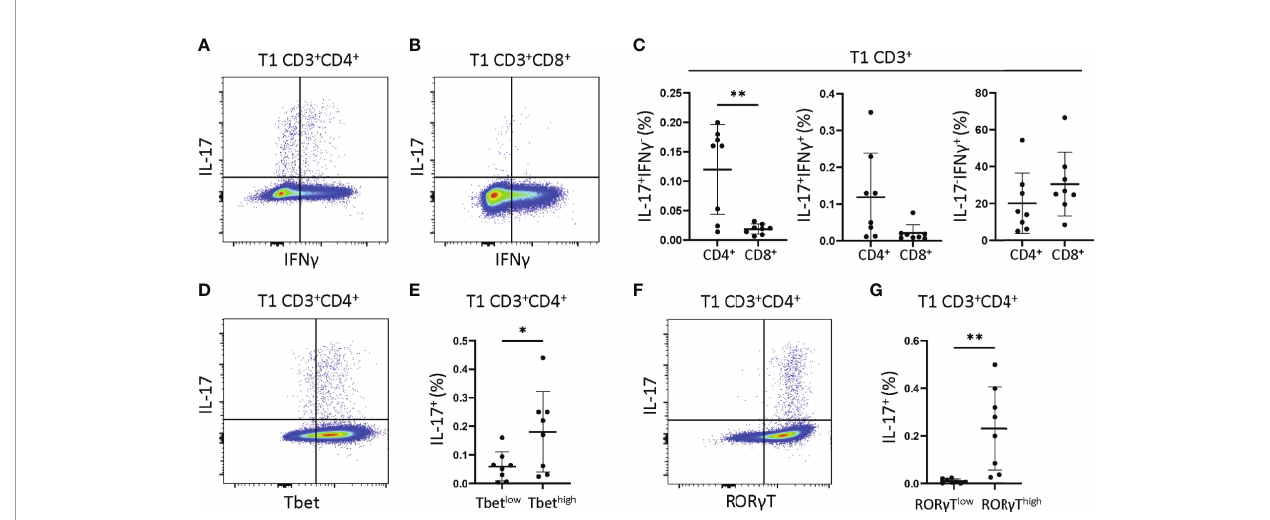
FIGURE 4 | JIA T1 cells have single IFN g + and IL-17 + and dual IFN g + IL-17 + cells that express Tbet and ROR g T. JIA T1 cells were assessed with fl ow cytometry to identify IFN g + and IL-17 + cell subsets. Representative fl ow cytometry plot from JIA T1 cells showing IFN g and IL-17 positive cells and gating for (A) CD3 + CD4 + cells and (B) CD3 + CD8 + cells. (C) JIA T1 CD3 + cell frequency of CD4 + and CD8 + cells that are IFN g - IL-17 + , IFN g + IL-17 + , and IFN g + IL-17 - . (D) Representative fl ow cytometry plot from JIA T1 CD3 + CD4 + cells showing IL-17 and Tbet. (E) JIA T1 CD3 + CD4 + cells showing frequency of IL-17 positive cells in Tbet low and Tbet high subsets. (F) Representative fl ow cytometry plot from JIA T1 CD3 + CD4 + cells showing IL-17 and ROR g T. (G) JIA T1 CD3 + CD4 + cells showing frequency of IL-17 positive cells in ROR g T low and ROR g T high subsets. Shown is mean with standard deviation. Analysis by Welch ’ s t-test with *p<0.05,